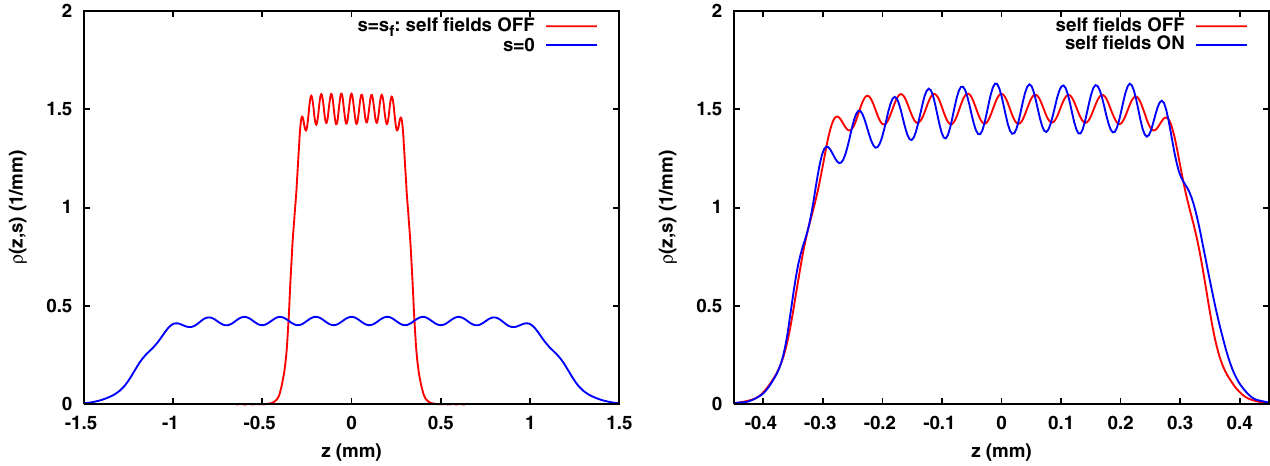
¼ 200 (cid:4) m . Left: s ¼ 0 and s ¼ s 0